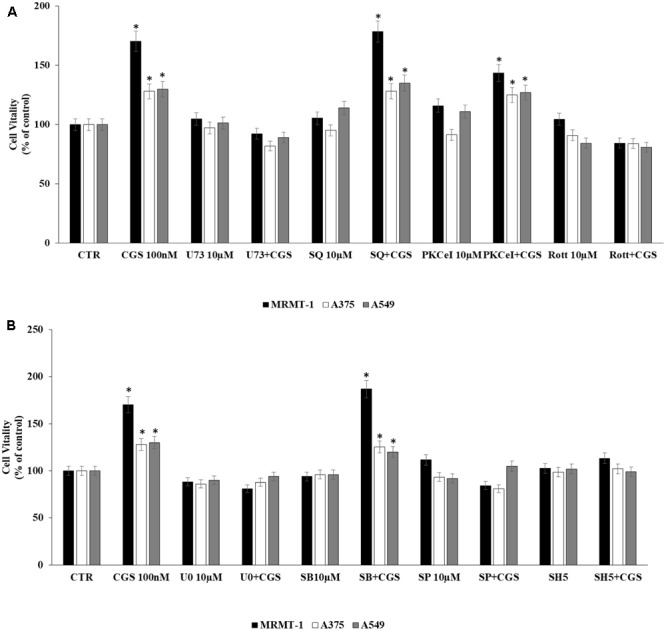
Signaling pathways involved in cell proliferation induced by CGS 21680 in cancer cell lines. Effect of 100 nM CGS 21680 on A375, MRMT cell viability (48 h) as well as in A549 (24 h) and inhibition by 10 μM U73, SQ, PKC𝜀-I, and Rott (A), 10 μM SB202190 (SB), U0126 (U0), SP600125 (SP), and SH5 (B) by DELFIA Cell Proliferation Kit. Solutions were made up in DMSO and then diluted in cell culture medium (0.1 max 0.2% of DMSO). An equal amount of DMSO was used in control cells (CTR) incubated for 24 h in case of A549 and 48 h in case of A375 and MRMT-1. ∗P < 0.01 compared with CTR. Means ± SE values from four experiments are shown. Analysis was by one way ANOVA, followed by Dunnett’s test.